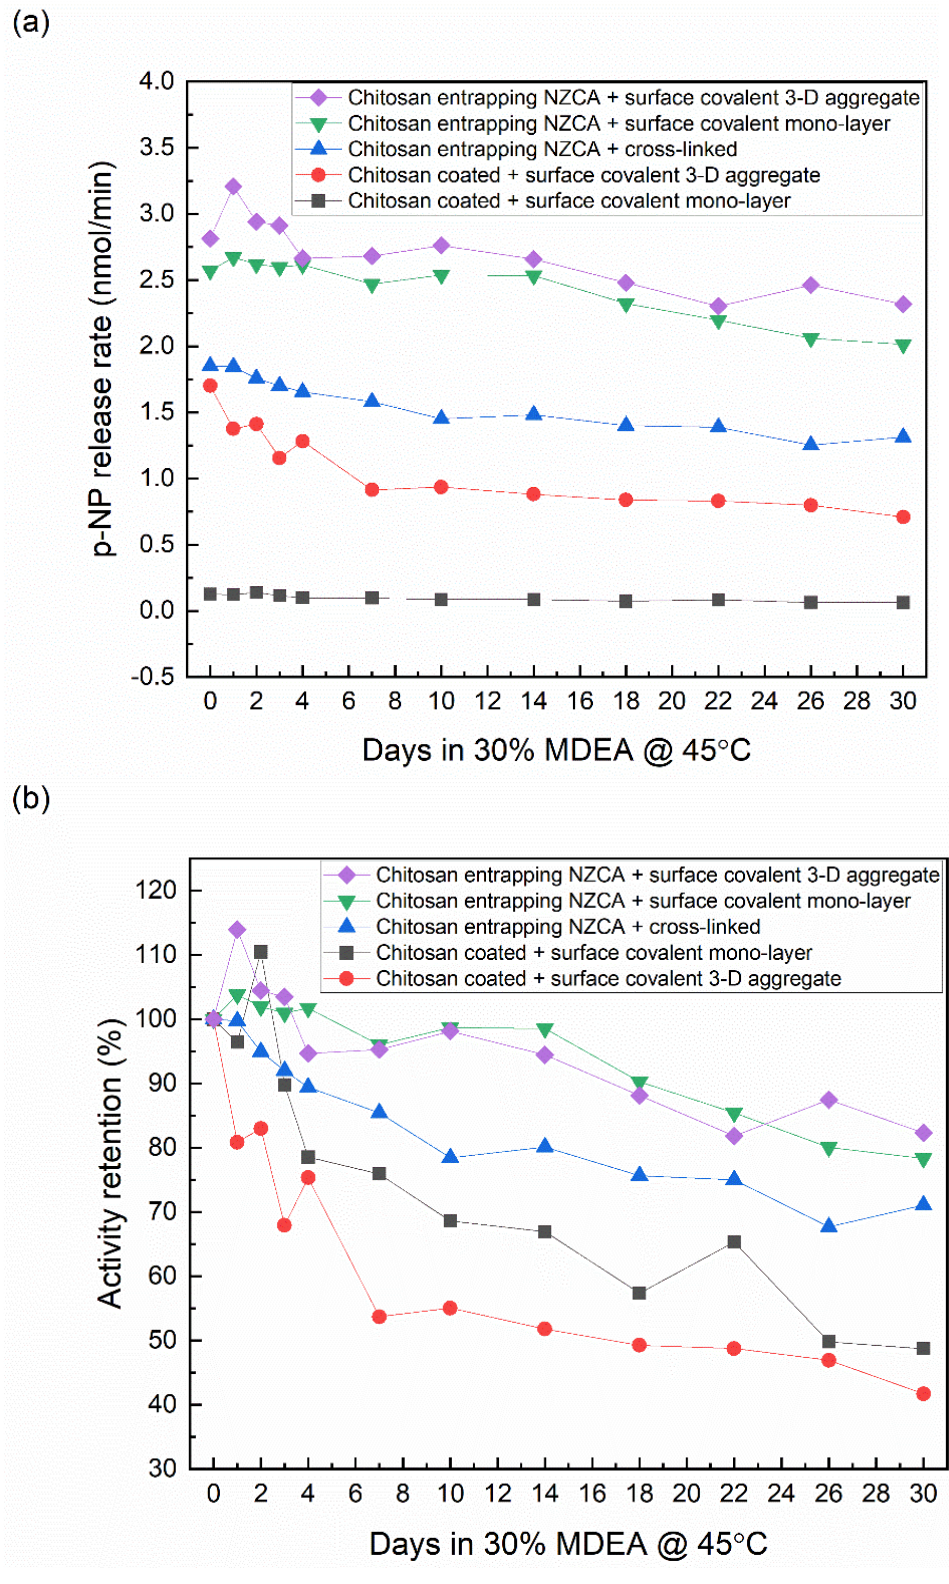
Figure 5. Long-term heat and solvent stress test of biocatalytic textiles samples fabricated using various methods involving crosslinking agent. Residual activities were expressed as p-NP release rate ( a ) and as percent activity retention ( b ). Table 3. Active enzyme loadings measured for different immobilization strategies by the esterase assay, compared to the maximum CO 2 absorption measured in a laboratory scrubber at L/G 30 mL/L using 10 wt% K 2 CO 3 solvent.